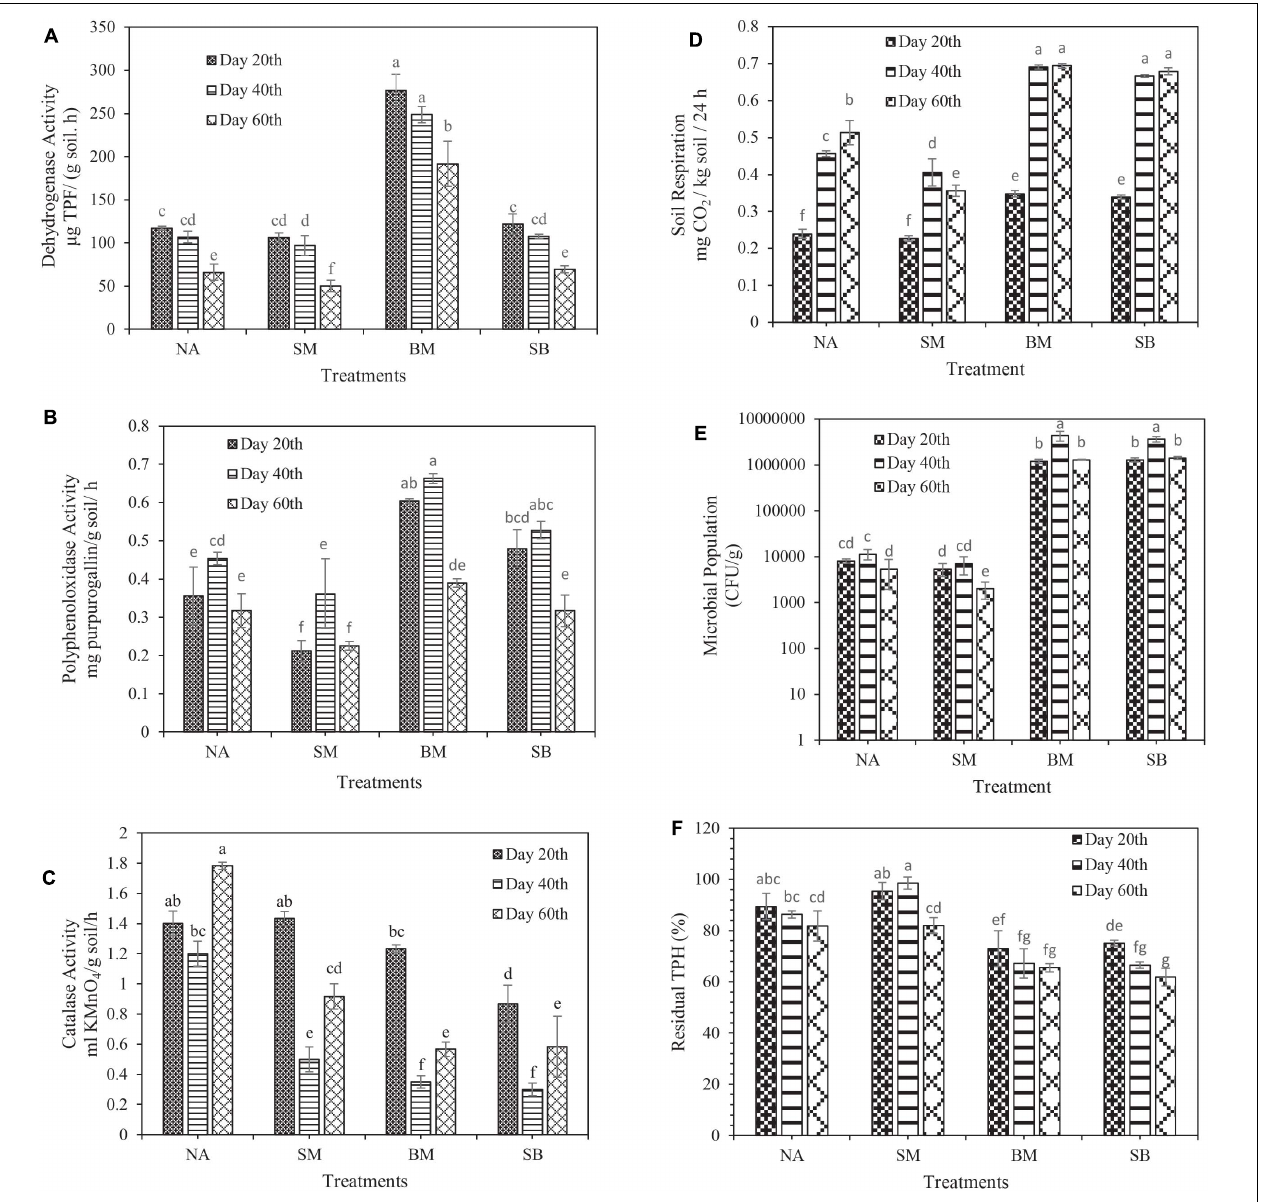
FIGURE 3 | Evaluation of changes in biological characteristics of crude oil-contaminated soil and biodegradation of TPH during 60 days of incubation. (A) Dehydrogenase activity, (B) polyphenol oxidase activity, (C) catalase activity, (D) soil basal respiration, (E) microbial population, and (F) biodegradation of TPH. (NA, natural attenuation; SM, bio-stimulated microcosm; BM, bacterialized microcosm, and SB, combined bio-stimulated microcosm and bacterialized microcosm). Means with the same letters are not significantly different at ( P ≤ 0.01). Error bars indicate the standard deviation ( n =